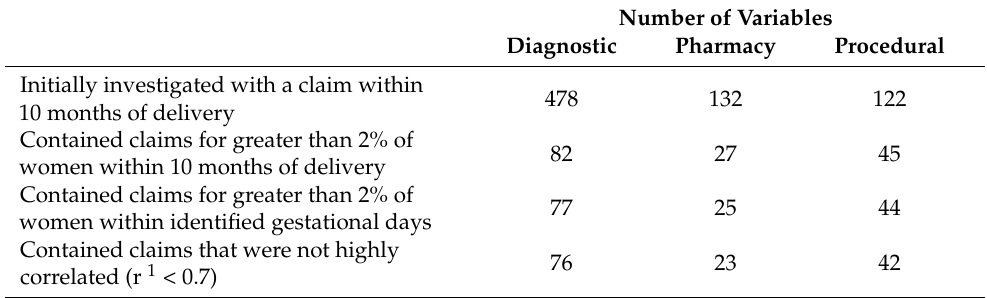
Table 2. Progression of the Number of Variables for Diagnostic, Pharmacy, and Procedural Categories. Number of Variables Diagnostic Pharmacy